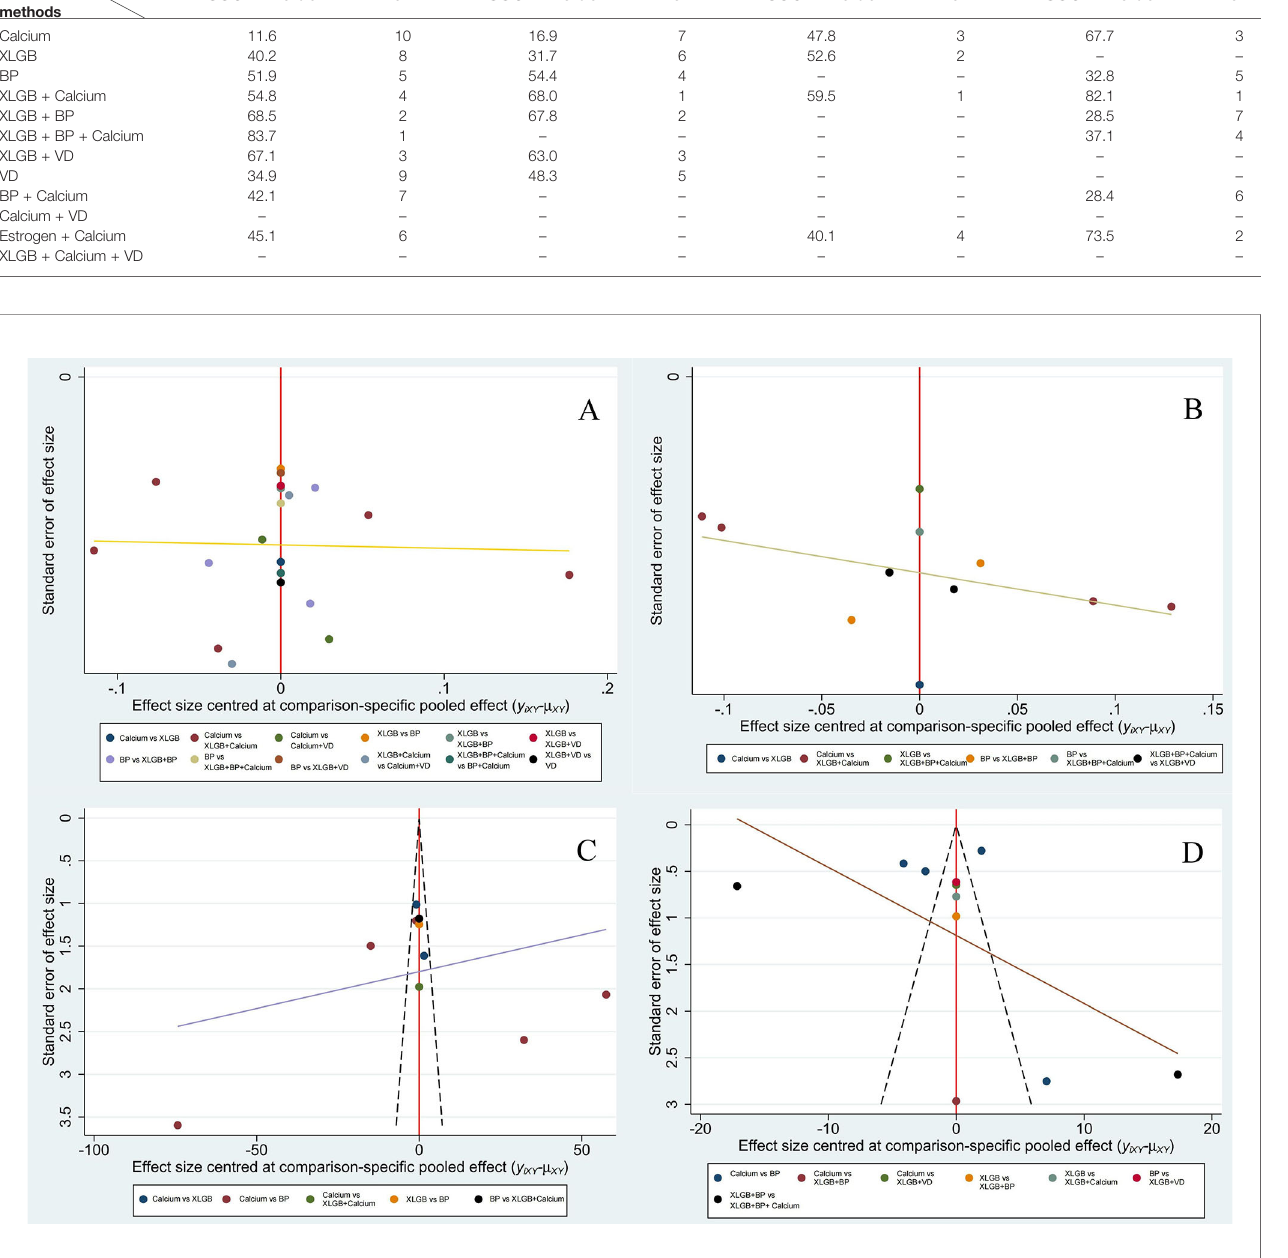
FIGURE 4 | Comparison-adjusted funnel plot of lumbar BMD (A) , BMD of the femoral neck (B) , BGP (C) and ALP (D) .